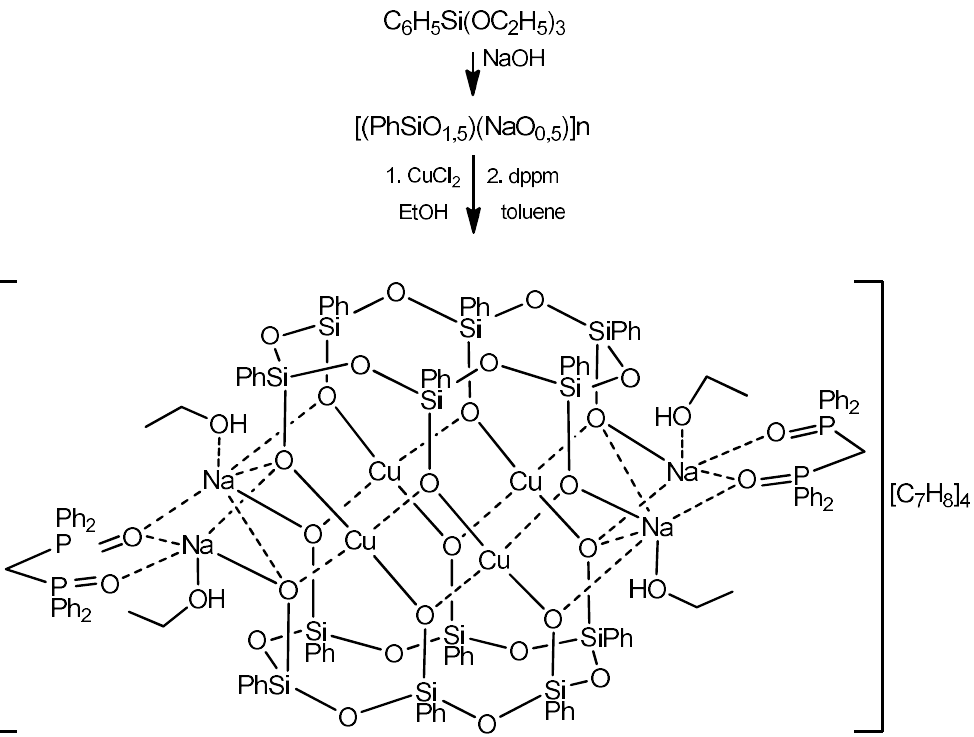
Figure 2. Ionic complexes with copper ions redistributed between silsesquioxane and 1,2-bis(diphenylphosphino)ethane ligands (Ref. [39]). Left : Compound C with four copper(II) ions in the cage unit. Right : Compound D with nine copper(II) ions in the cage unit.